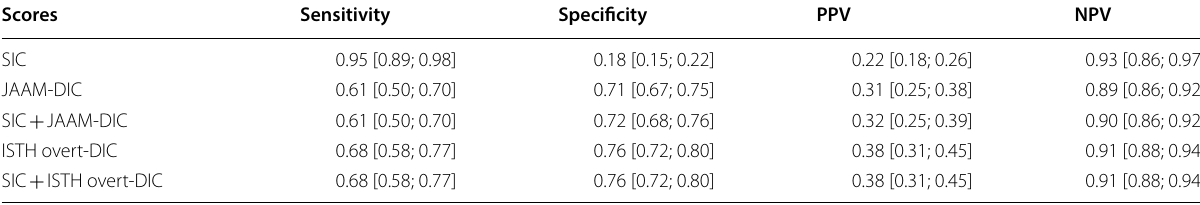
PPV positive predictive value, NPV negative predictive value